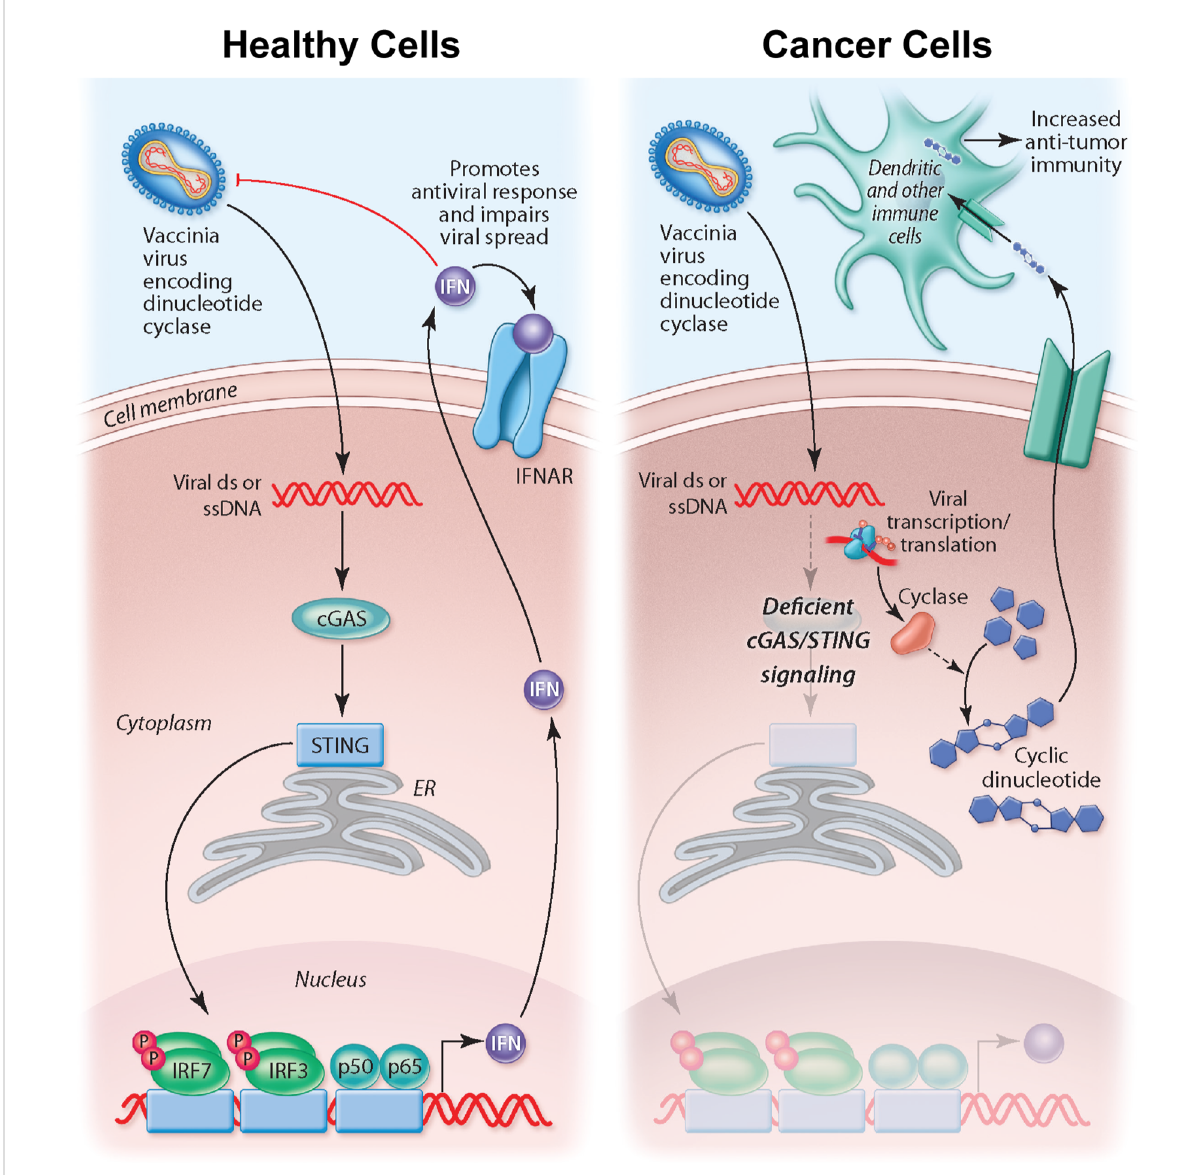
FIGURE 6 Overview of working model for STINGPOX ’ s therapeutic effects. In healthy cells, STING signaling is active, and STINGPOX replication would be signi fi cantly hindered due to increased activation of IFN signaling. In several cancer types, immune signaling, and more speci fi cally, STING signaling is de fi cient; therefore STINGPOX-induced cyclic di-AMP production does not enhance IFN signaling/production in infected cells enabling viral replication and expression of disA. disA catalyzes synthesis of c-di-AMP. Through lysis or secretion, c-di-AMP is transferred to extrinsic phagocytic cells, including dendritic cells, which help promote an anti-tumor